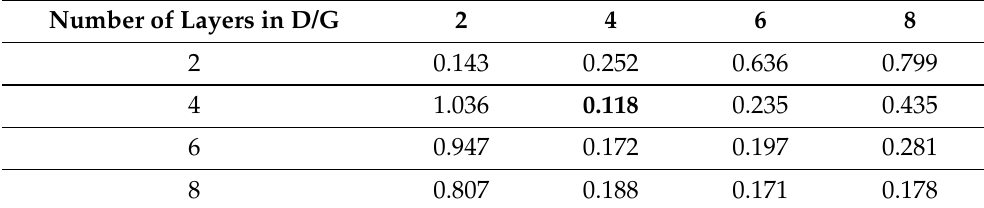
Table A3. tf n -values for varying number of layers in both networks.